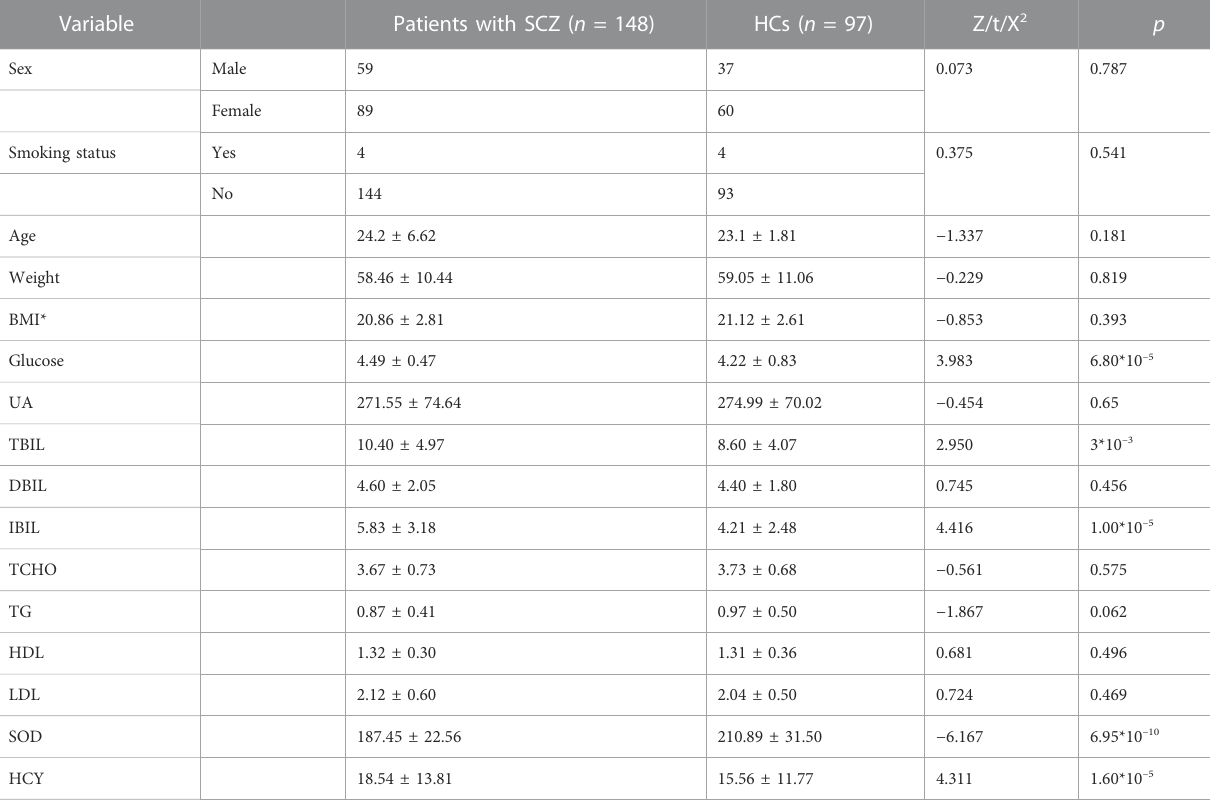
TABLE 1 Demographic characteristics and peripheral biochemical indicators of patients with SCZ and